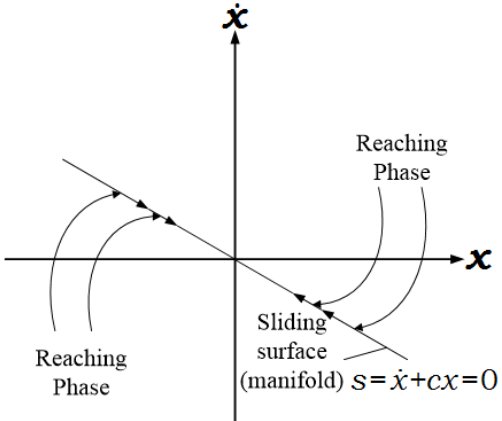
Figure 1. Sliding surface design consists of sliding phase and reaching